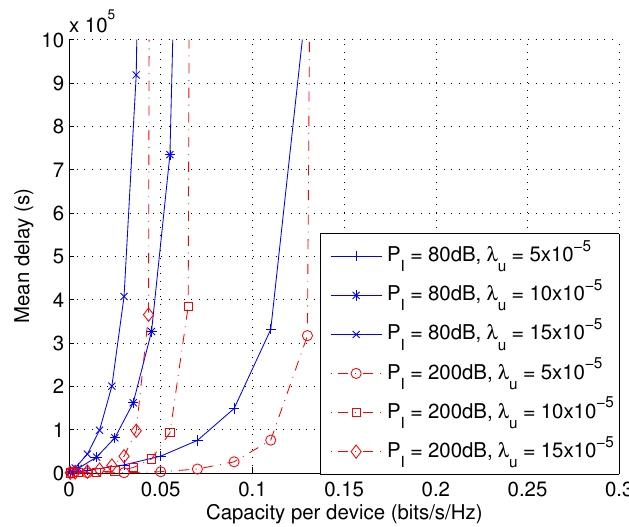
Figure 10. Mean delay ¯ D as a function of capacity per device C with varying transmit power P I and